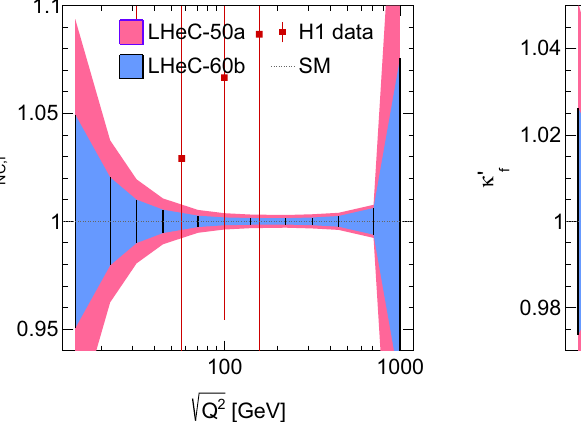
Fig. 13 Scale dependence of the anomalous form factors ρ (cid:9) (μ 2 ) (right) with μ 2 = − Q 2 for the scenarios (left) and κ (cid:9) f LHeC-50a and LHeC-60b. The highest precision is obtained in